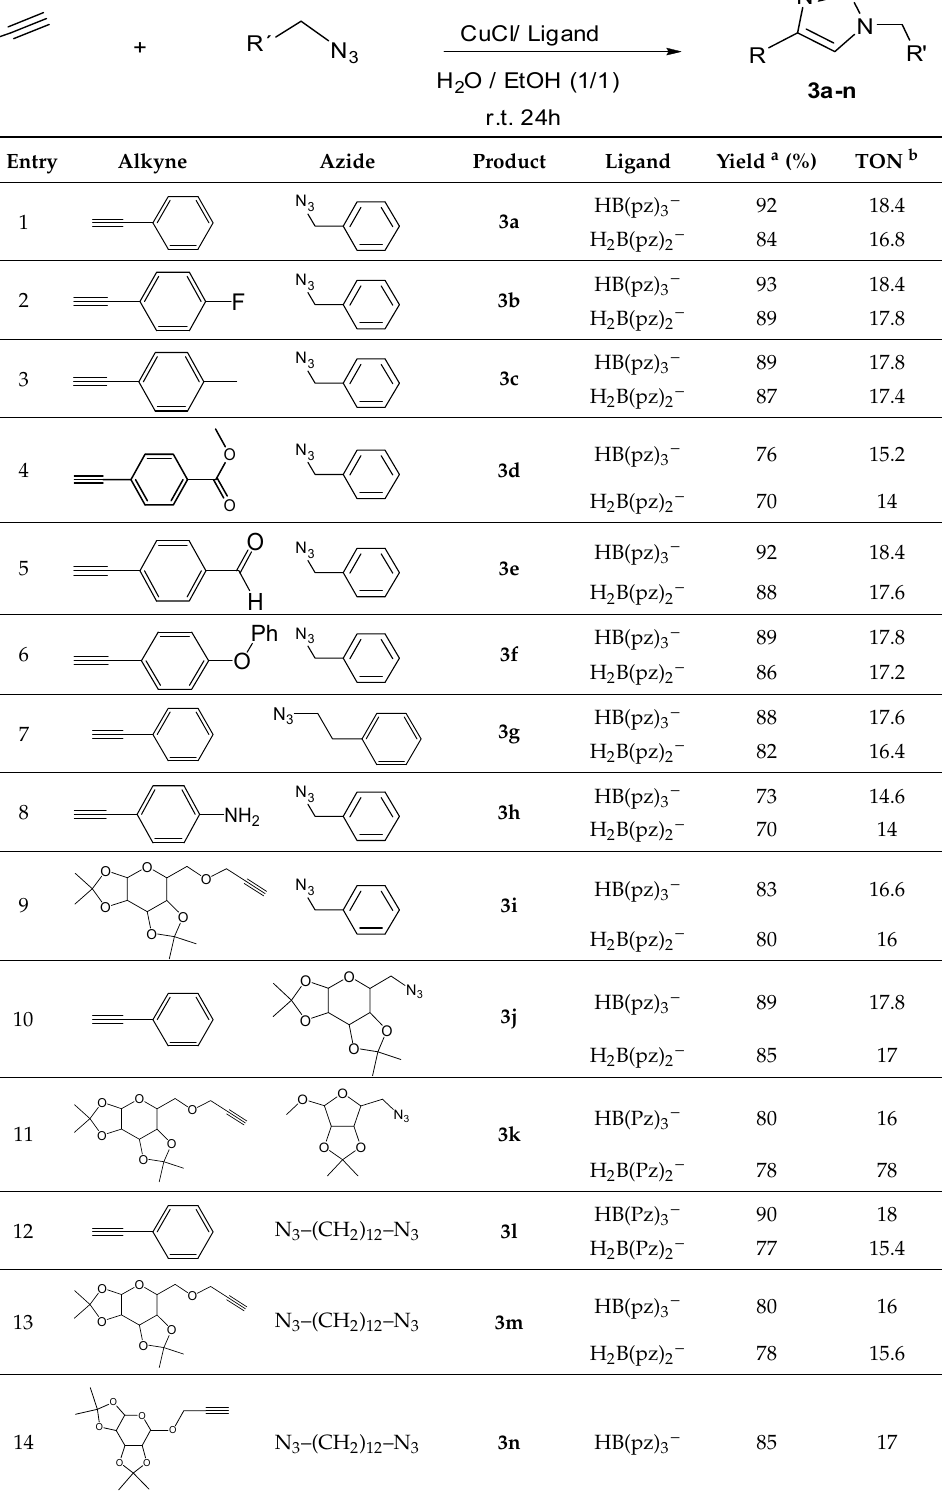
Table 3. 32CA reactions of azides and alkynes catalyzed by poly(pyrazolyl)borate-copper(I).